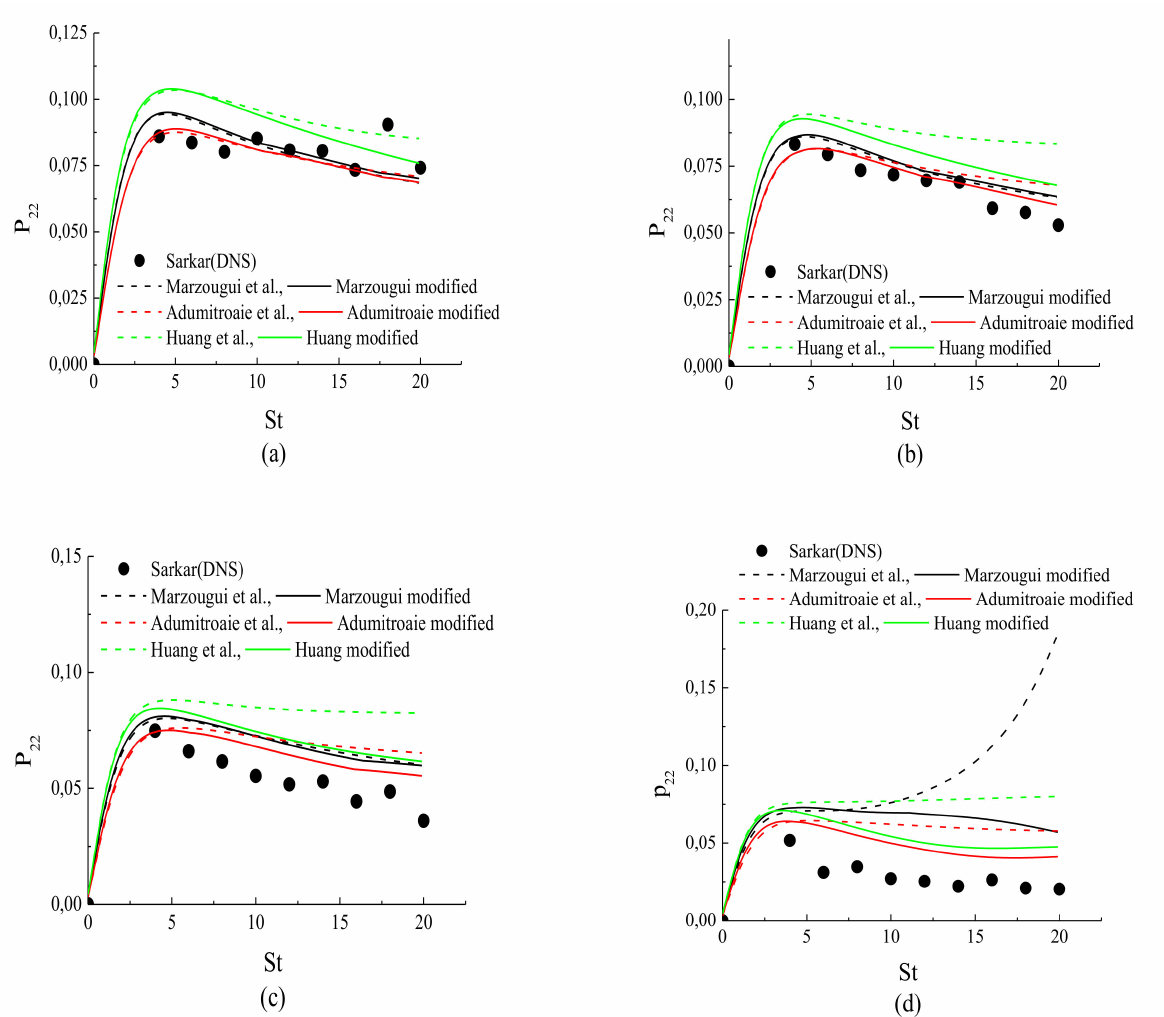
Figure 7. Time evolution of the pressure-strain component, P 22 in the following cases: ( a ) A1; ( b ) A2; ( c ) A3; ( d )